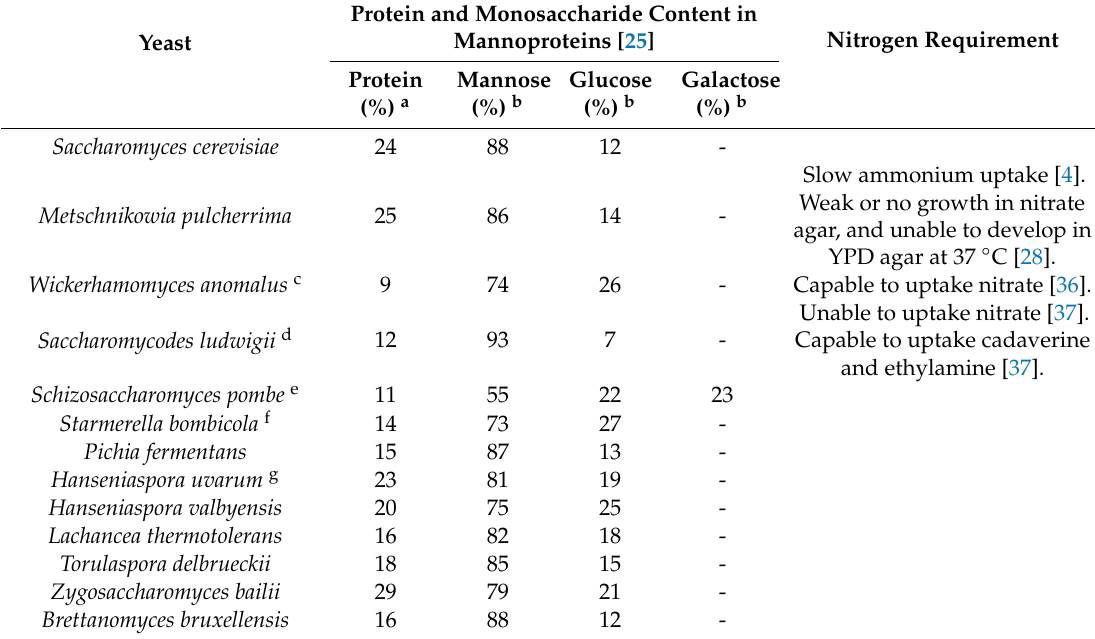
Table 1. Some non- Saccharomyces yeasts with the potential to release